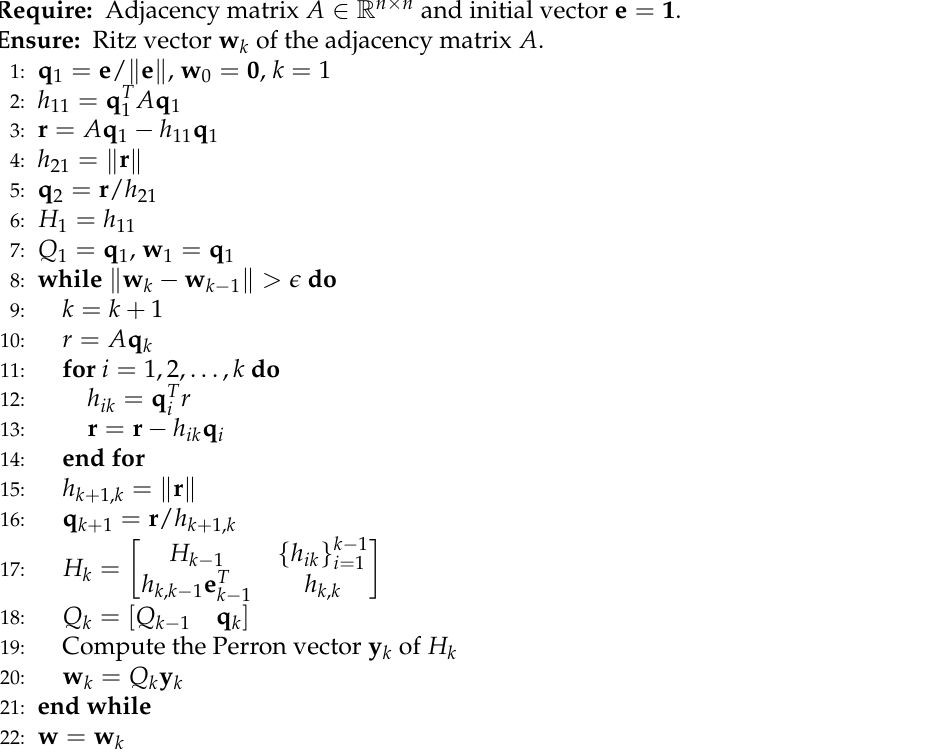
Algorithm 3 Estimate the Perron vector of matrix A with the Arnoldi method with initial vector e